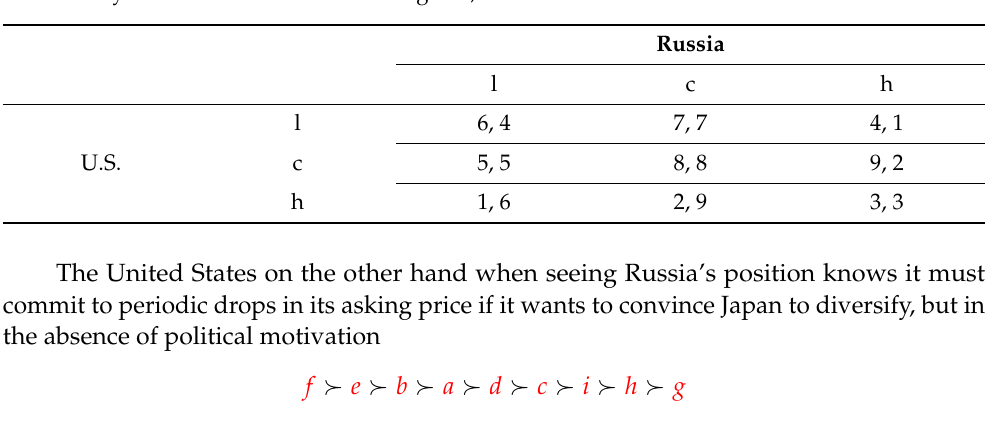
Table 8. Payoff matrix for Russia-U.S. subgame, unsanctioned